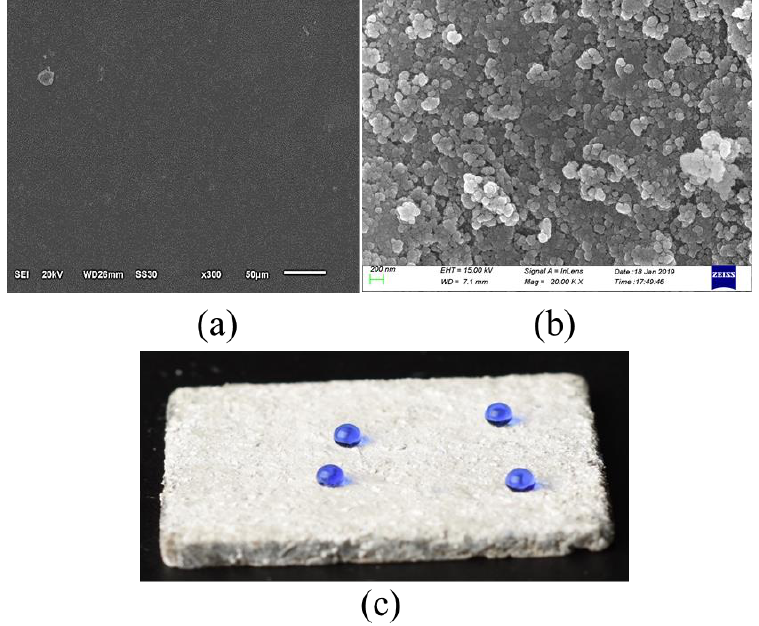
Figure 3. The first 30 s when DGEBA was dispersed in ethyl alcohol ( a – e ).